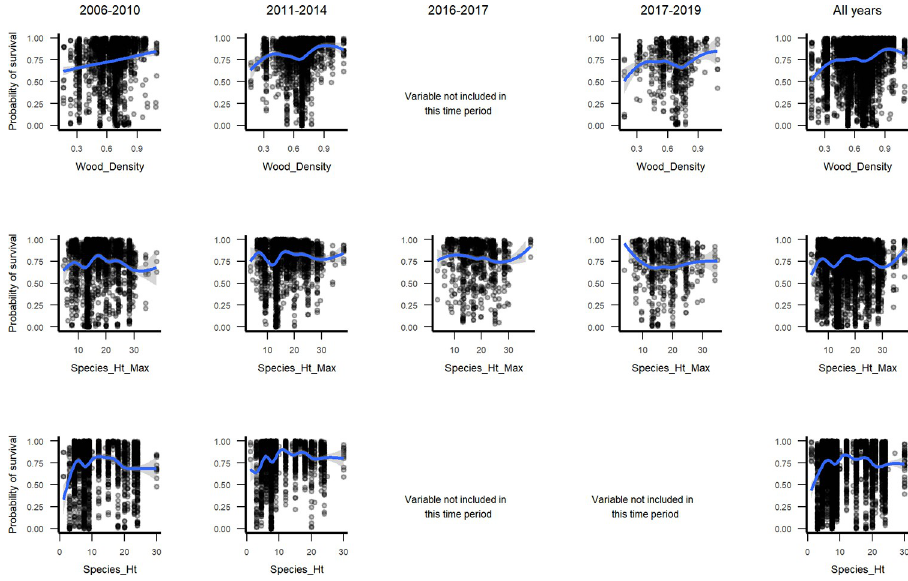
Fig 5. Marginal plots through time for wood density, maximum species height and typical species